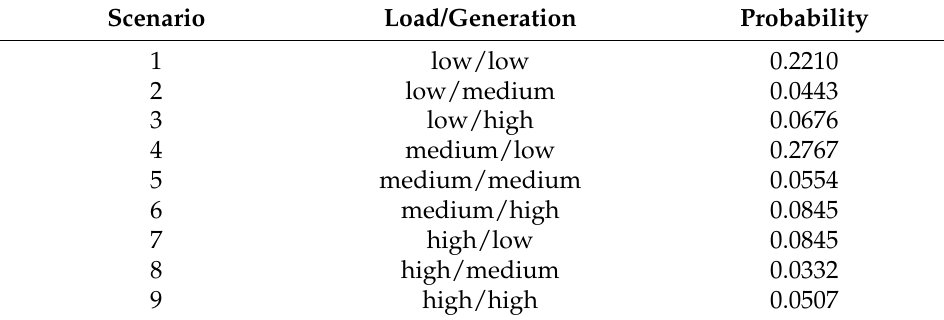
Figure 4. Modified CIGRE low voltage benchmark test system. Table 2. Scenarios of generation and load.